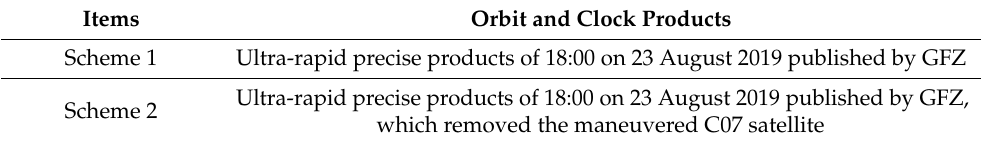
Table 1. The differences between Scheme 1 and Scheme 2.